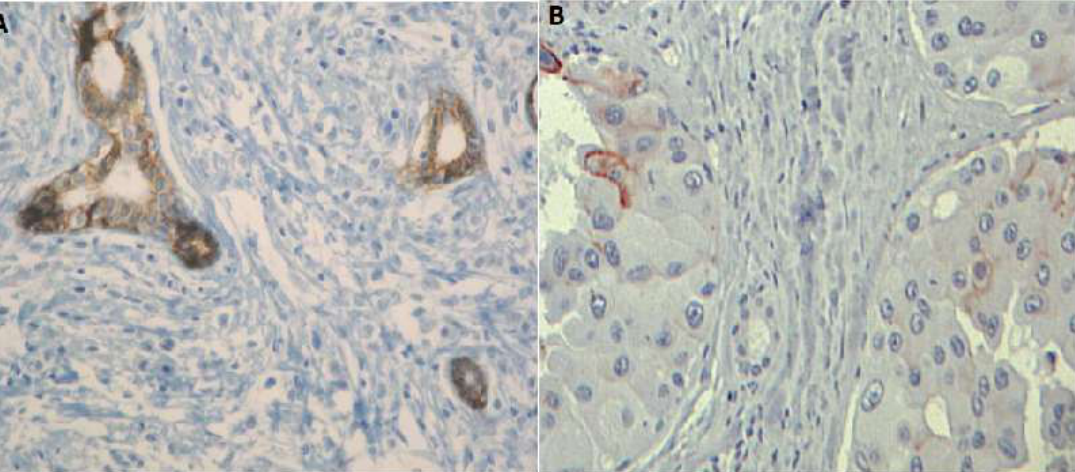
Figure 5. ( A ) Immunohistochemical staining for E-cadherin in bilateral invasive lobular carcinoma, showing an homogenous loss of E-cadherin expression and presence of E-cadherin in normal tissue X 200. ( B ) Immunohistochemical staining for E-cadherin in in situ ductal and lobular carcinoma, showing a heterogeneous loss of E-cadherin expression X 200.